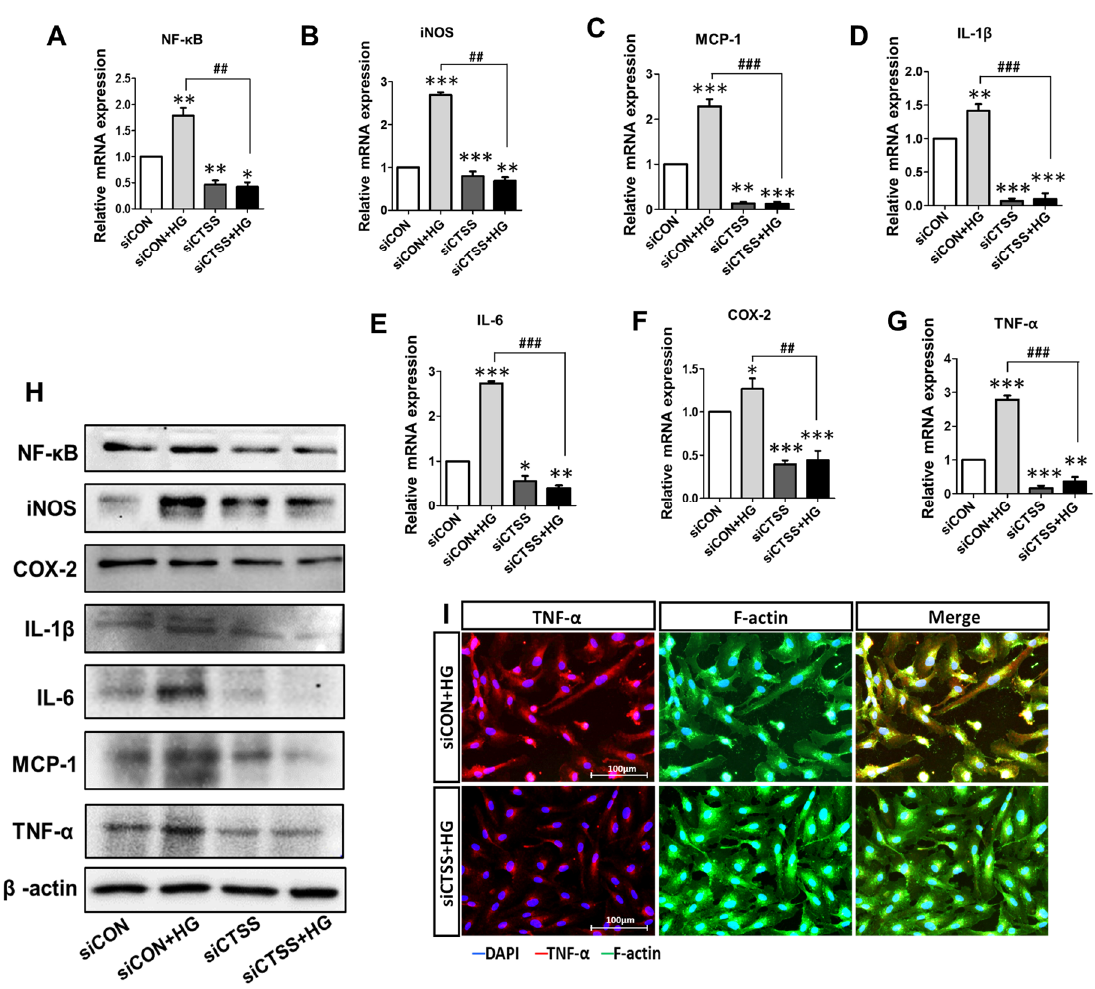
Figure 2. High expression of pro-inflammatory genes and proteins after glucose treatment and low expression observed after cathepsin S (CTSS) knockdown. ( A – G ) mRNA levels of pro-inflammatory gene markers. ( H ) Protein expression of pro-inflammatory chemokines and cytokines. ( I ) Immunoflu- orescence analysis of TNF- α protein expression. Values are expressed as mean ± SEM ( n = 3 biological replicates per group). p < 0.05 indicates statistical significance. * p < 0.05, ** p < 0.01, *** p < 0.001 versus control samples; ## p < 0.01, ### p < 0.001 versus HG-treated